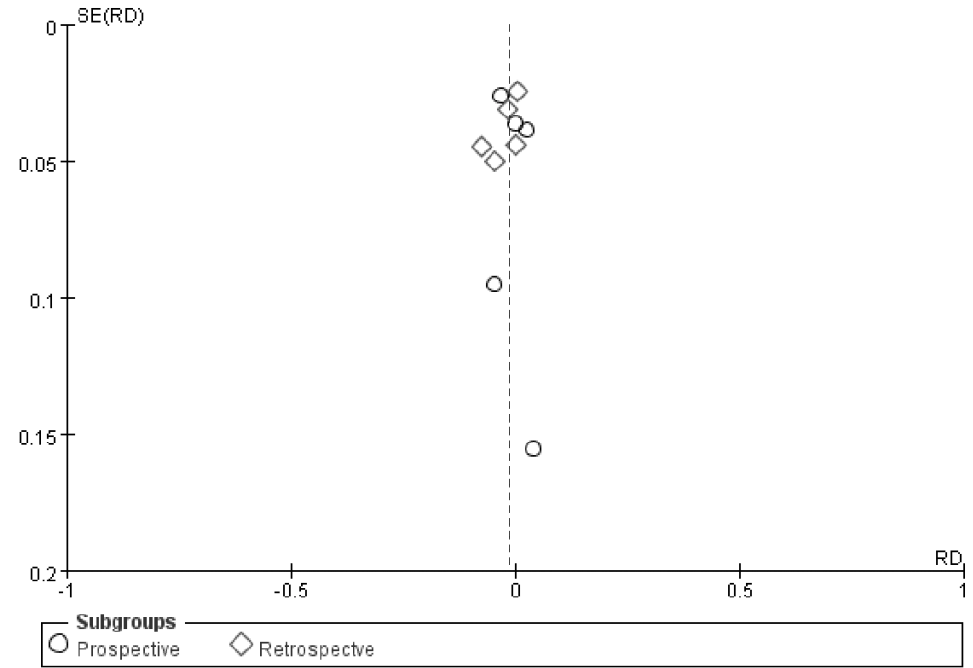
Figure 4. Funnel plot of effect estimates plotted against risk of bleeding.